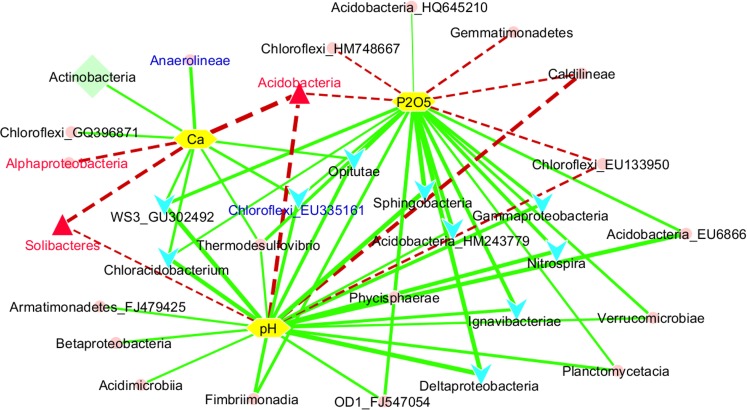
Network-inferred correlations of bacterial classes to soil parameters.Soil parameters (yellow hexagons) included soil pH, available phosphorus (P2O5), and exchangeable Ca2+. Aqua V-shapes indicate the classes that decreased with cultivation time, and the red triangles indicate the classes that increased with cultivation time. The light green diamond (Actinobacteria) indicates changes associated with soil depths. Red and blue fonts indicate the classes that were more and less populous, respectively, in unhealthy samples compared to healthy samples. The solid green lines indicate positive correlations while dashed red lines indicate negative correlations. Edge width is the correlation value. All correlations are significant at p<0.05 (one-way ANOVA, post hoc Tukey’s test).